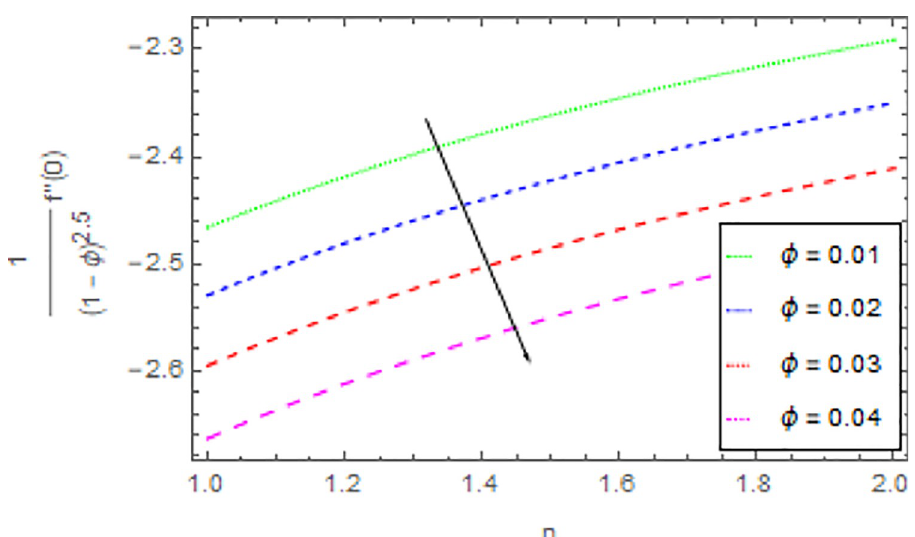
Fig 18. Deviation in skin friction coefficient of velocity ( x − direction) against ϕ and n when Pr = 1000, m = 0.10, M = 2.50, δ = 0.40, β = 1.00 and Nr = 0.20.